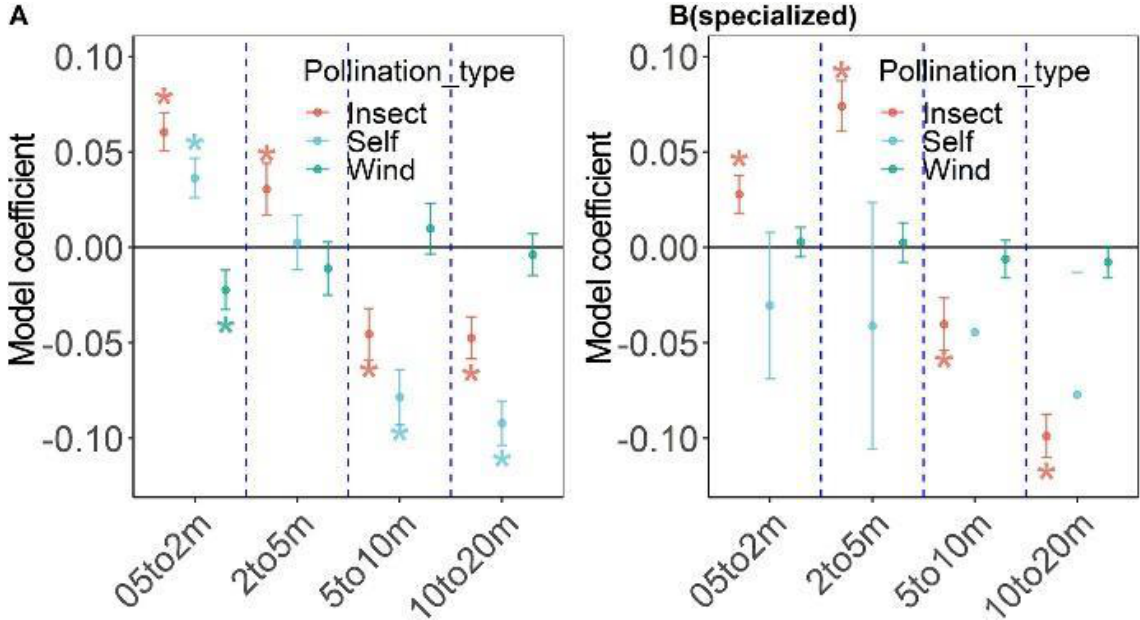
Figure 3. Model coefficients from the generalized linear mixed model (GLMM) of species richness in relation to canopy densities of four vegetation strata. Analysis was conducted within (A) three groups of insect pollination, wind pollination and self pollination and (B) three groups of specialized insect pollination, specialized wind pollination and specialized self pollination. 05to2m means the canopy density of 0.5-2 m vegetation strata. 2to5m means the canopy density of 2-5 m vegetation strata. 5to10m means the canopy density of 5-10 m vegetation strata. 10to20m means the canopy density of 10-20 m vegetation strata. Y axes indicate coefficients of predictors, which are also listed in Appendix